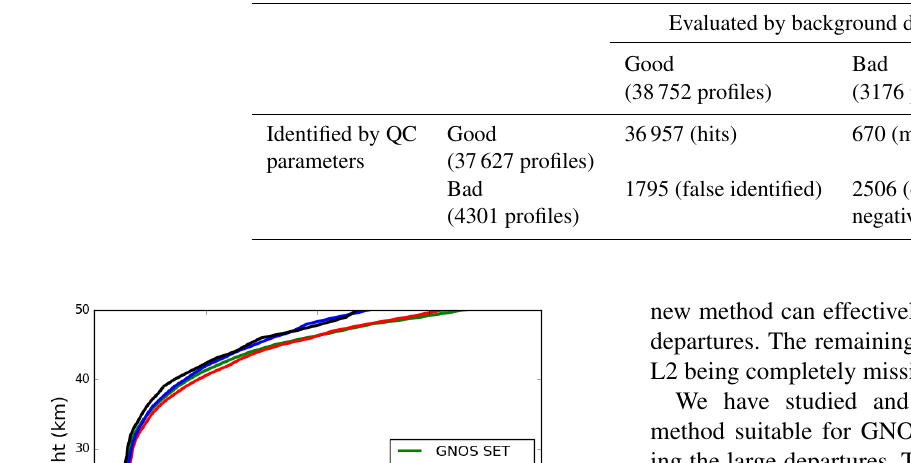
Table 4. The 2 × 2 table values.